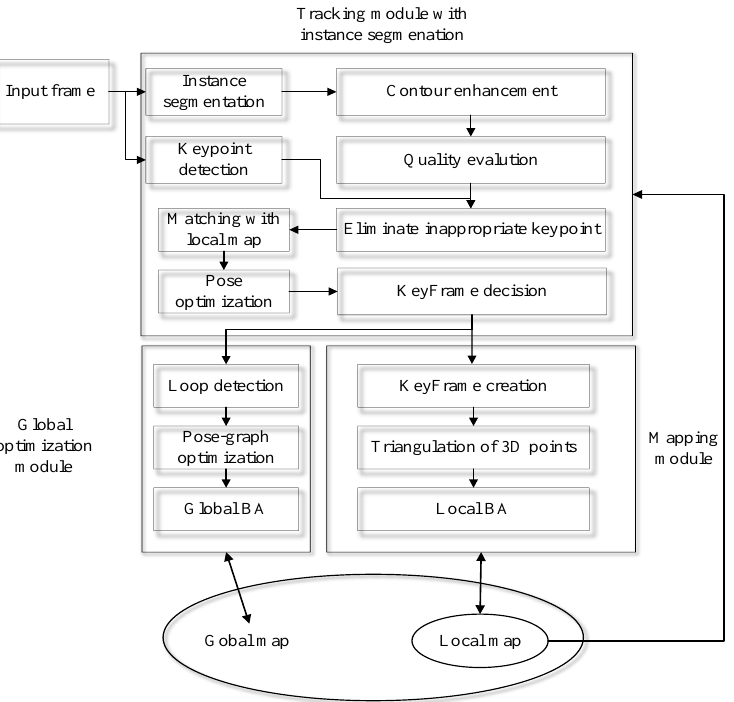
Figure 1. Visual SLAM algorithm with pose estimation optimized by instance segmentation archi-